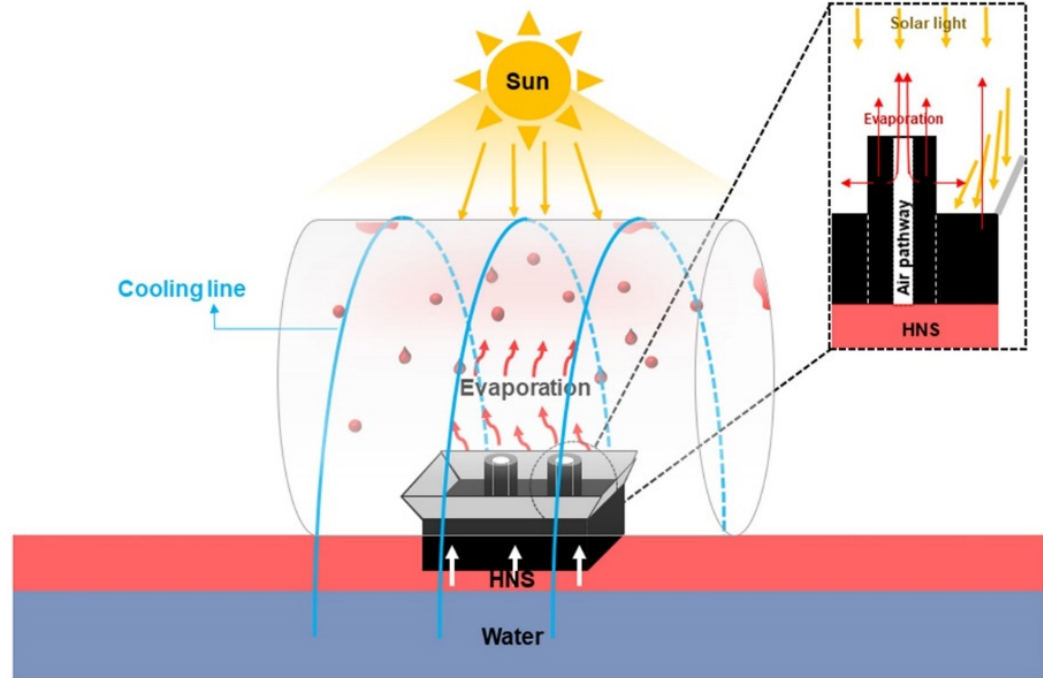
Figure 1. Schematic illustration of an HNS trapping device consisting of the RPS for absorption and evaporation of HNSs, an Al mirror for focusing light, and a cooling system for condensation of HNSs.